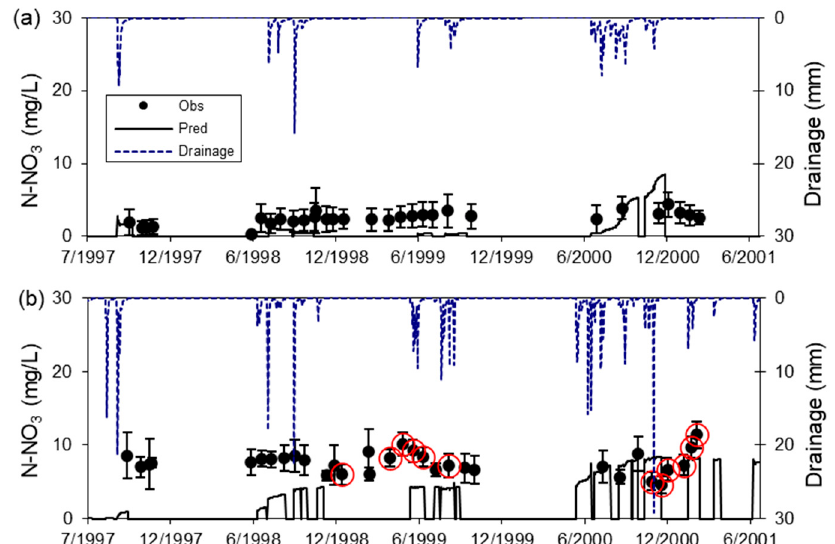
Figure 5. Predicted (Pred) and observed (Obs) nitrate (N-NO 3 ) concentrations in suction-cup solution samples for the ( a ) MM and ( b ) RM systems (points indicate the mean of the observed data; whiskers indicate the standard error of the mean; circled points indicate where 100% of suction cups had a water sample). Note: Predicted drainage is shown along the top x axes.